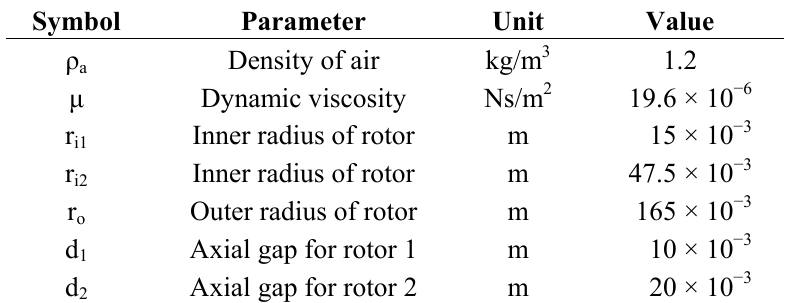
Table 6. Parameters used in the calculation of power loss due to air